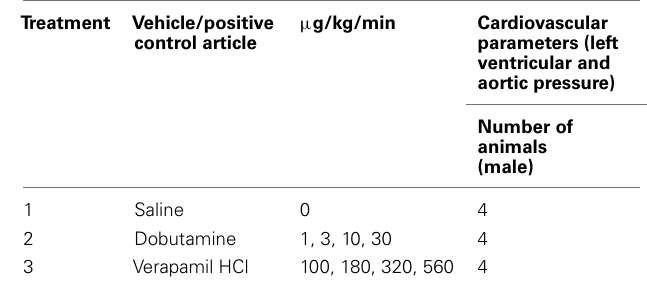
Table 3 | Treatments and dose details used in the study for saline, dobutamine, and verapamil